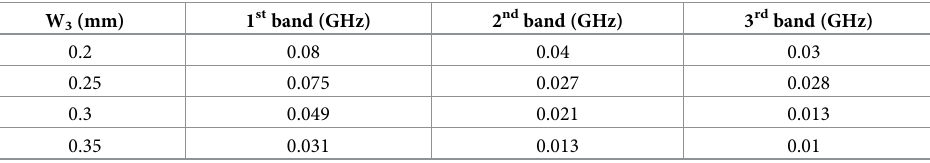
Table 3. Simulated result of coupling coefficient for different values of W 3